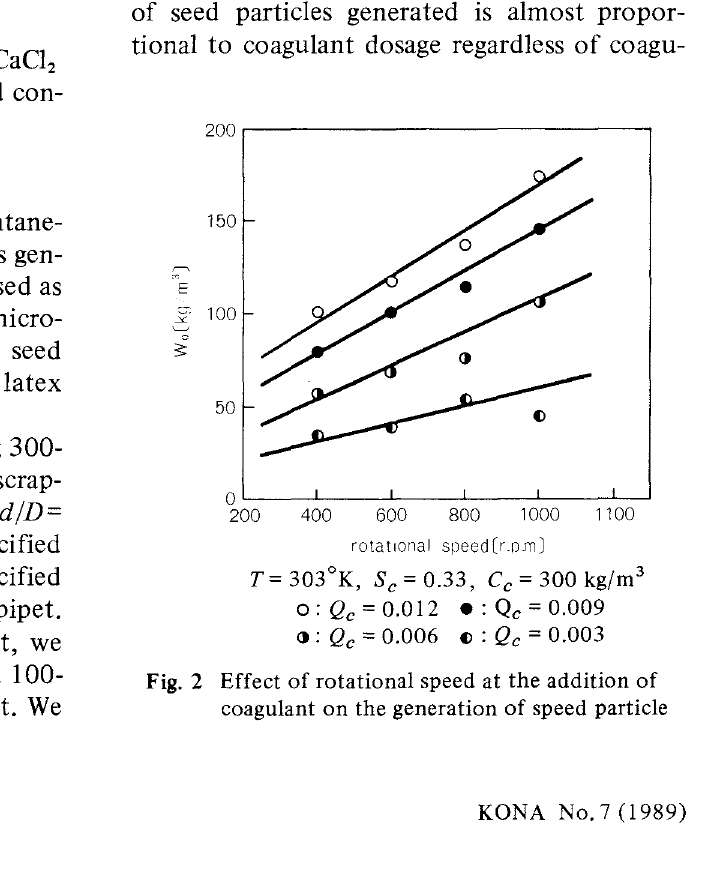
Fig. 1 Effect of volume of coagulant added in latex on the generation of seed particle